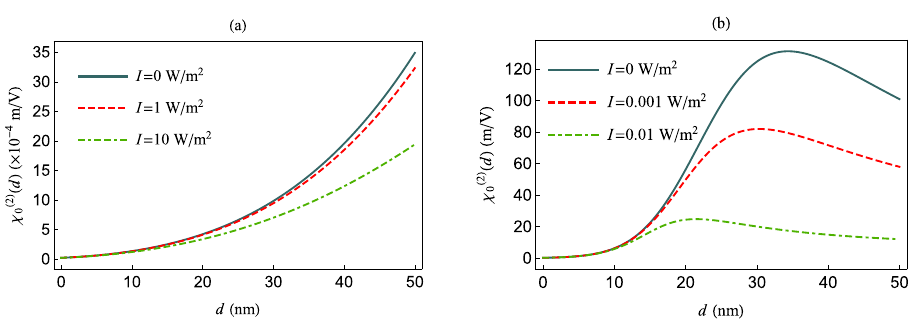
( 2 ) ( δ = 0 ) as a function of d , for δ = 0 and γ Figure 8. χ 0 The QS transition dipole moment is along the z -axis ( a ) and x -axis ( b ), respectively.